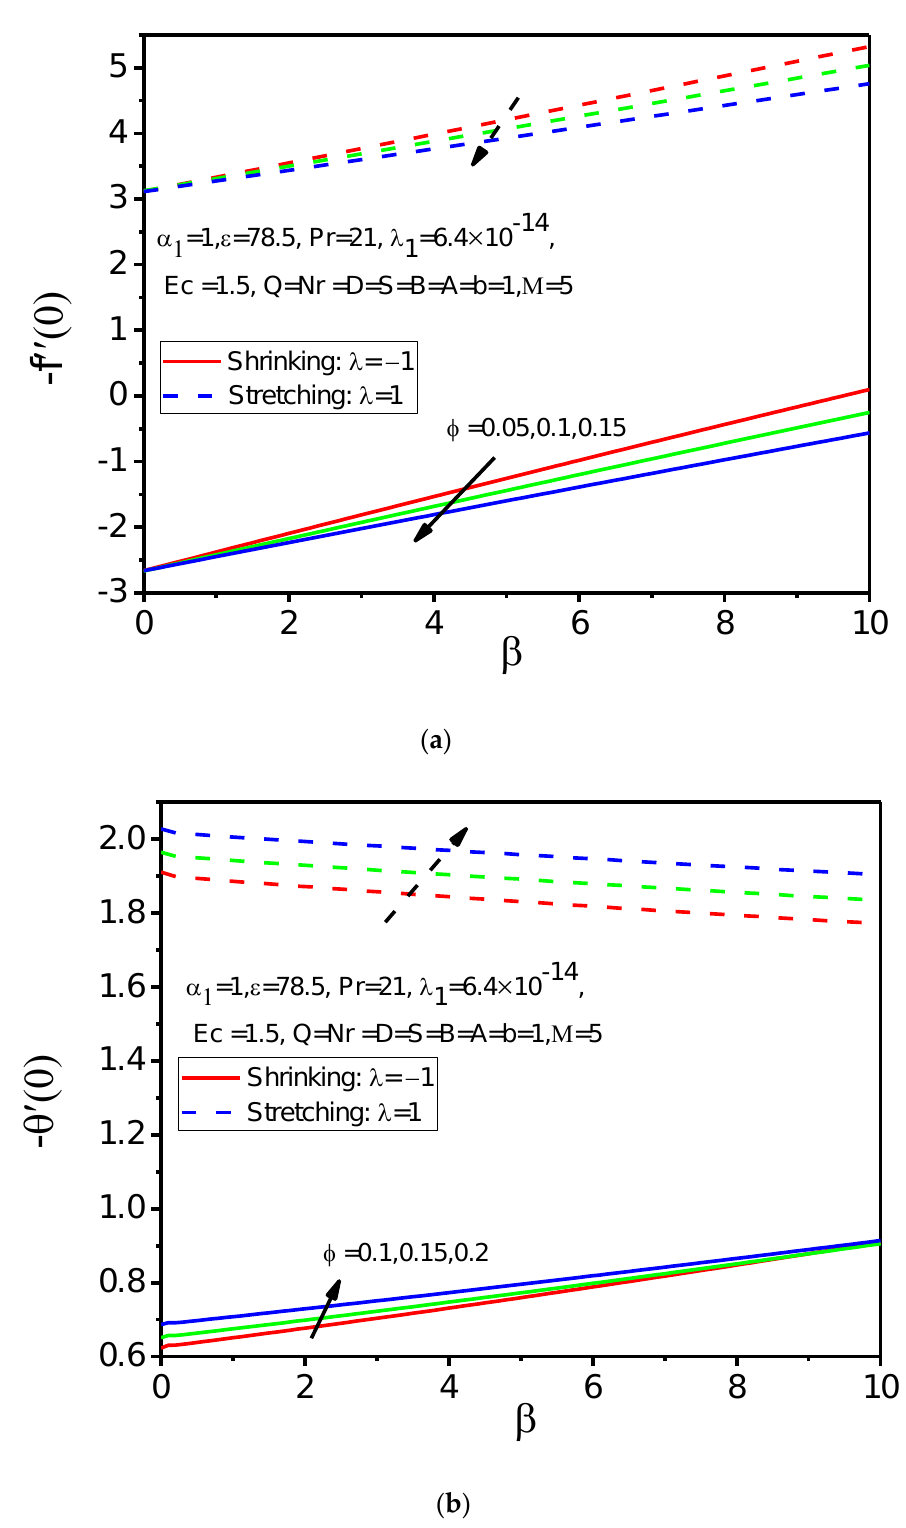
Figure 16. Influence of ϕ against β on ( a ) Skin friction coefficient, ( b ) Rate of heat